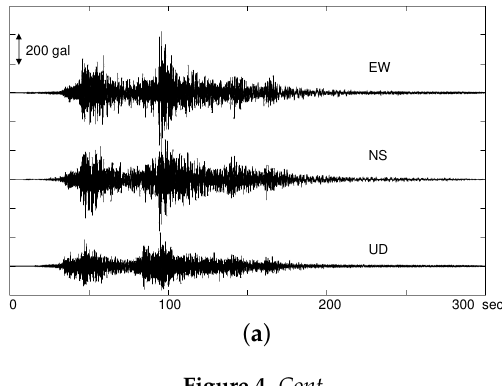
Figure 3. Finite-element model of ground. Dark gray areas indicate cut ground (hard), while light gray areas indicate fill ground (soft). Mesh used to model the ground geometry is shown in the enlarged